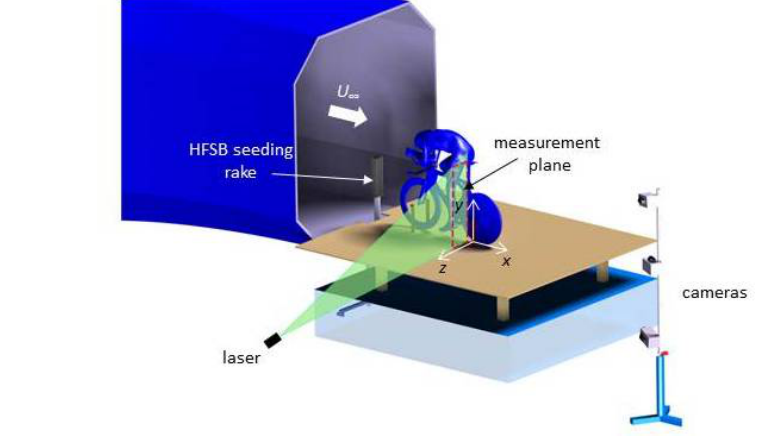
Figure 2. Illustration of the experimental